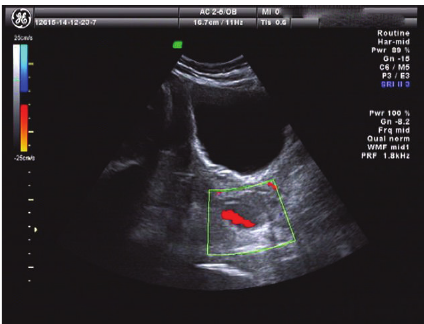
Figure 1: Sonographic findings showing unilocular cysts containing hyperechoic fluid and irregular wall with some blood flow signals.